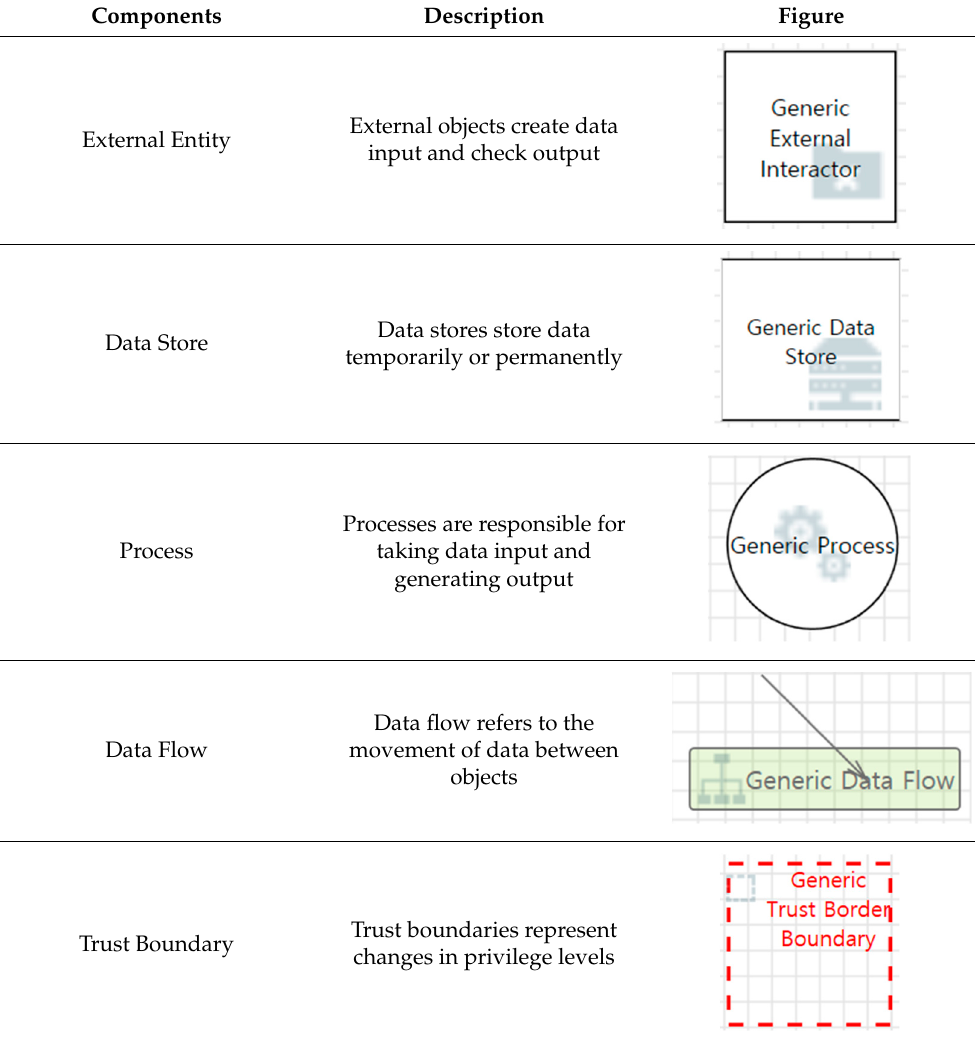
Table 5. Components of DFD.